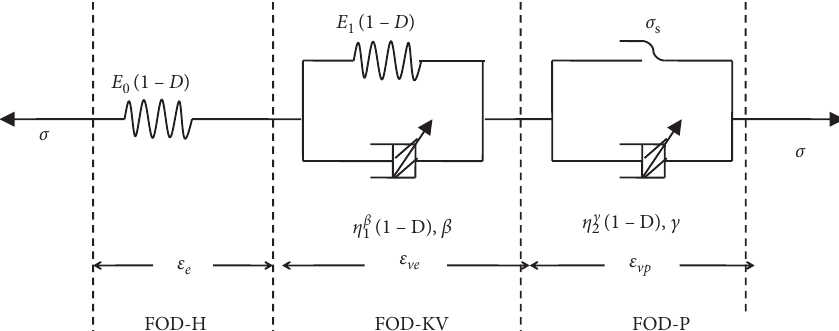
Figure 9: Nonlinear unloading rheological constitutive model based on the fractional-order